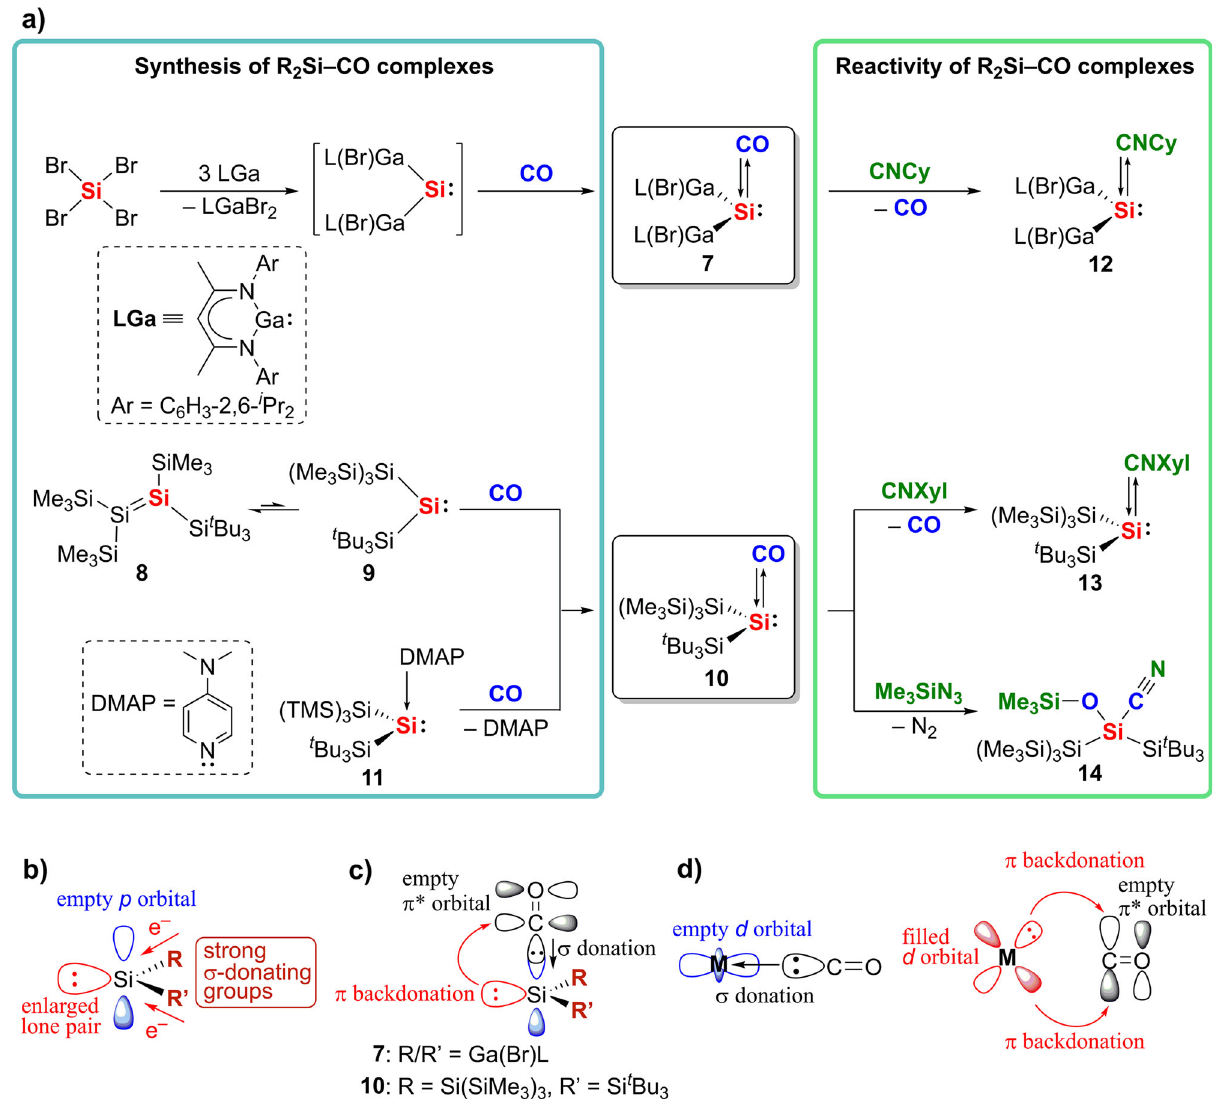
Fig. 2 Silicon carbonyl complexes. Synthesis of silicon carbonyl complexes ( 7 and 10 ) and their reactivity ( a ). Important molecular orbitals in silylenes bearing electropositive groups ( b ) and the frontier orbital interactions in silicon carbonyl complexes ( c ). Frontier orbital interactions in transition-metal (M) carbonyl complexes ( d ). CNCy, cyclohexyl isocyanide; CNXyl, 2,6-dimethylphenyl